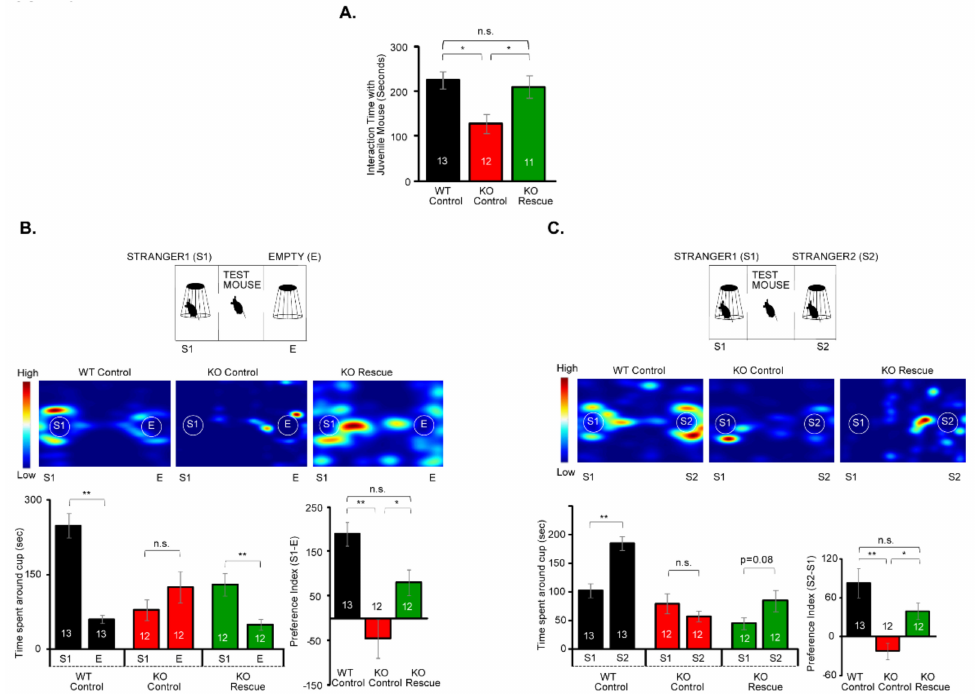
Figure 6. Re-expression of IQSEC2 in the mPFC rescues social behaviors. ( A ) Summary graph for interaction with a free-moving juvenile mouse in wild-type and IQSEC2 KO mice infected with control AAV (WT Control and KO Control), and IQSEC2 KO mice infected with IQSEC2 AAV (KO Rescue). Interaction with a juvenile mouse is restored in the KO rescue mice. ( B ) Experimental diagram (top), heatmap images (middle), and summary graphs (bottom) for social preference test in wild-type infected with control AAV (WT Control), IQSEC2 KO infected with control AAV (KO Control), and IQSEC2 KO mice infected with IQSEC2 AAV (KO Rescue). Preference for stranger mouse (S1) is restored in KO Rescue mice. ( C ) Experimental diagram (top), heatmap images (middle), and summary graphs (bottom) for social novelty preference